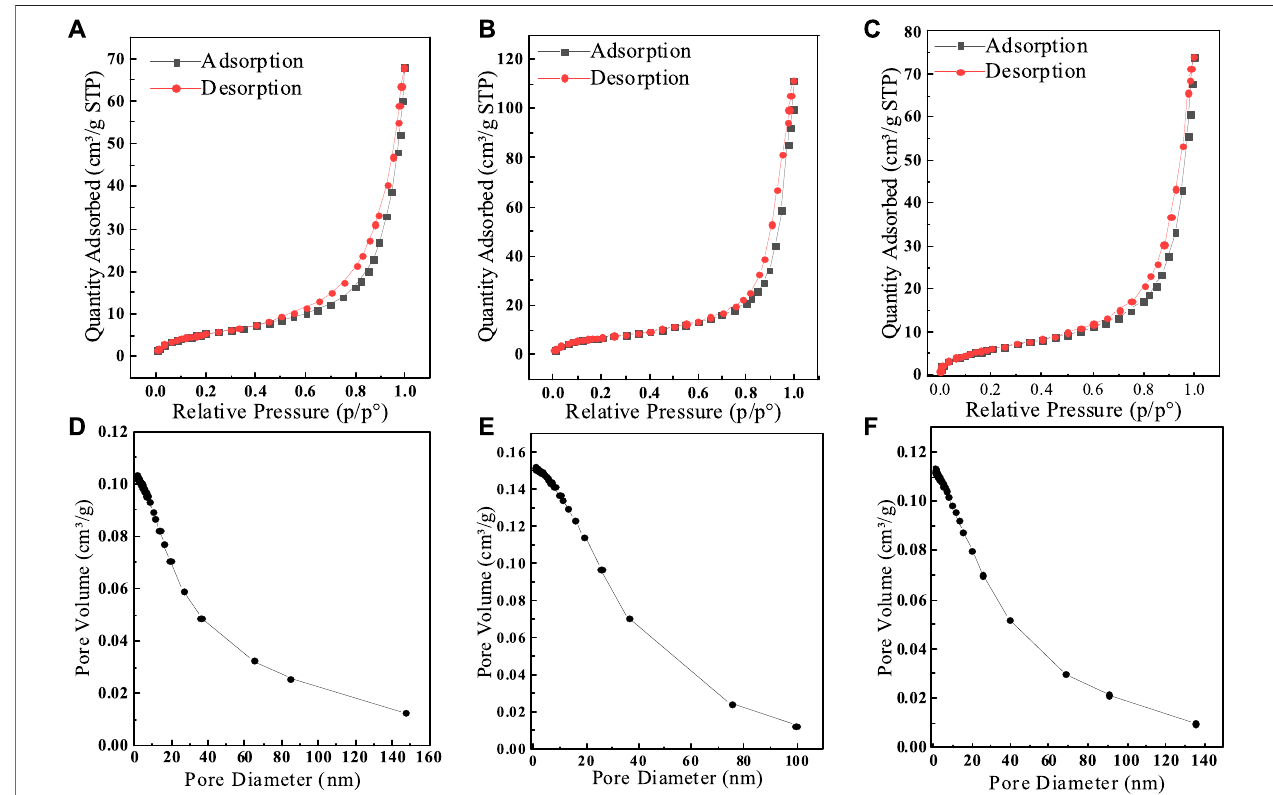
FIGURE 2 | (A) SAA, (B) C-SAA, (C) SAA oa Nitrogen adsorption-desorption curve and (D) SAA, (E) C-SAA, (F) SAA oa pore size distribution